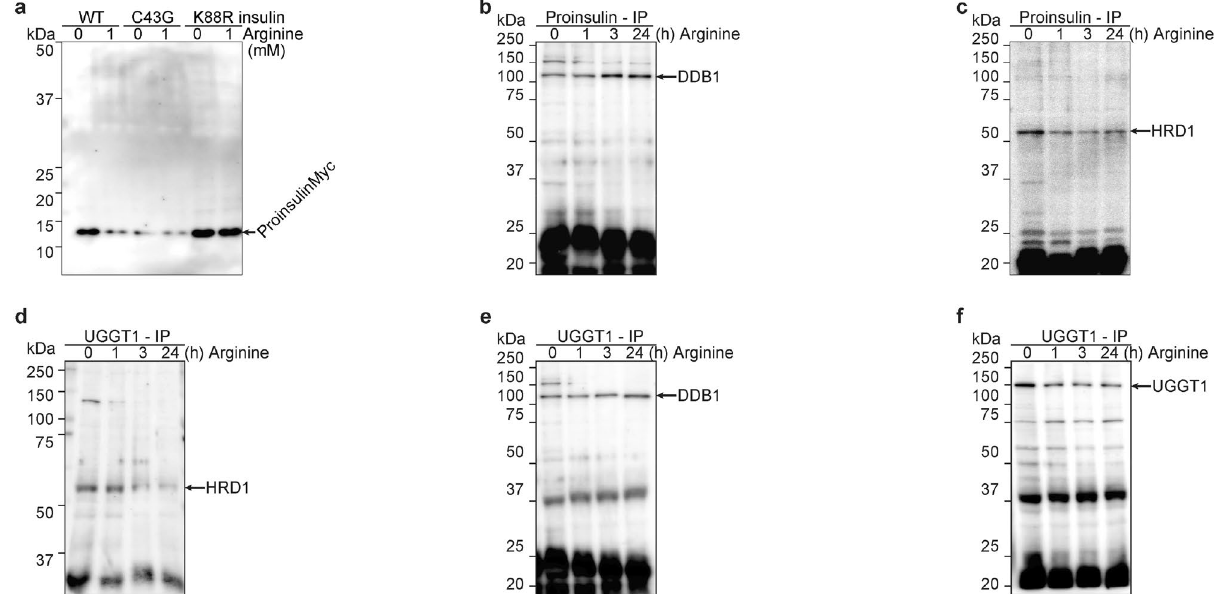
Figure 3. Arginine switches proinsulin associated E3 ubiquitin ligases from HRD1 to CRBN. ( a ) WT proinsulin was degraded after arginine administration, and C43G proinsulin was degraded with/without arginine, although K88R proinsulin was not degraded with/without arginine. Arginine was depleted for 30 min, and cells were treated with 0 or 1 mM arginine. The cell lysates were visualized with anti-Myc WB. ( b – f ) Both proinsulin and UGGT1 are associated with the E3 ubiquitin ligase DDB1 after arginine administration. Arginine was depleted from the medium for 30 min, and NIT1 cells were treated with 1 mM arginine for the indicated times (0, 1, 3, and 24 h). The cell lysates were IPed with proinsulin ( b and c ) or UGGT1 ( d – f ), and then these IP-ed lysates were visualized with DDB1 ( b , and e ), HRD1 (c and d), or UGGT1 ( f ,